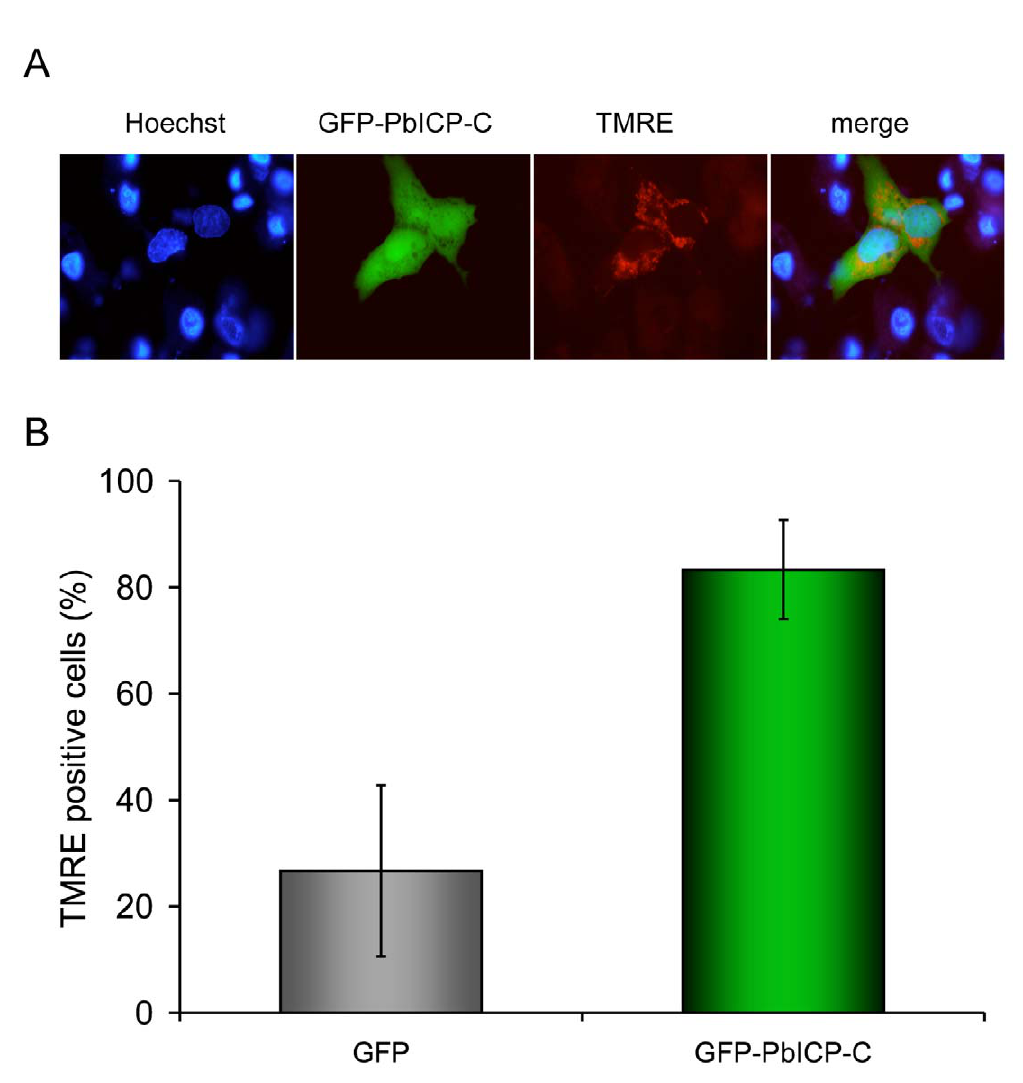
Figure 8. PbICP-C expression protects HepG2 cells against host cell death. ( A ) HepG2 cells were transiently transfected with plasmids leading to either cytosolic expression of GFP-tagged PbICP-C or GFP as a control. The transfection efficiency of HepG2 cells with the control plasmid and the GFP-PbICP-C plasmid (absolute numbers of GFP-positive cells/cover) were similar. Host cell death was induced by tBHP treatment for 4 h and analyzed by live imaging using TMRE staining of intact mitochondria (red). DNA condensation was visualized by Hoechst 33258 staining (blue). Dying cells exhibited condensed chromatin in the nucleus and a loss of the mitochondrial membrane potential. ( B ) Fluorescent cells were counted and the percentage of dead and viable cells was calculated. Presented are the means and standard deviations of three independent experiments. Cells expressing GFP-PbICP-C showed a significantly better survival following tBHP treatment in comparison to GFP-expressing cells.